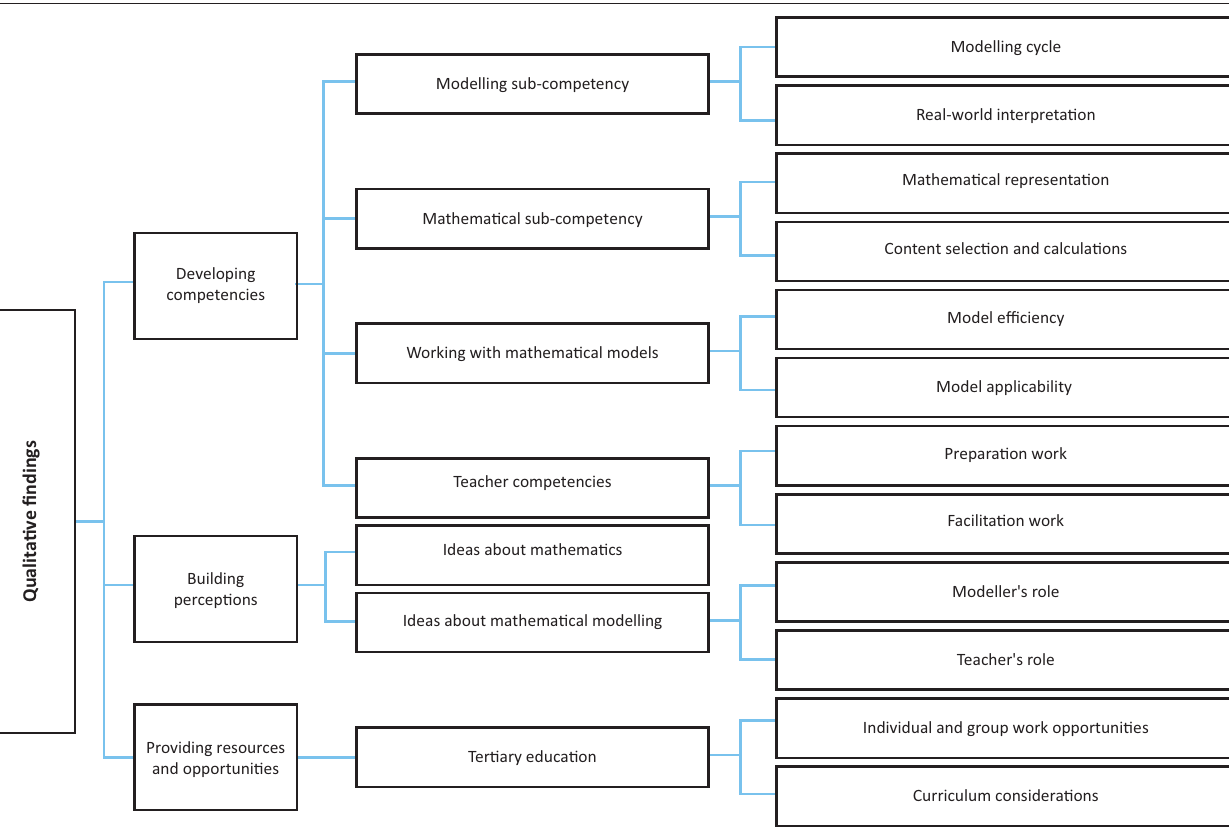
FIGURE 5: Reflective analysis and evaluation of all qualitative data: themes, categories, and